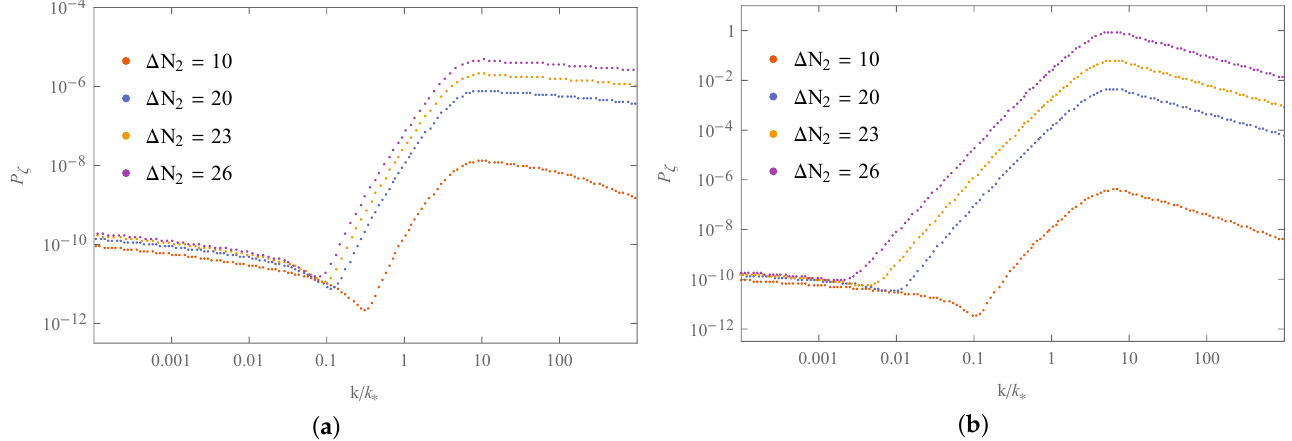
Figure 4. The power spectrum at γ = 0.1 (see the plot ( a )) and at γ = 1 (see the plot ( b )) for ∆ N 2 = 10,20,23,26, respectively. Table 3. The PBH masses estimated by using Equation (57) for the γ model with the values of